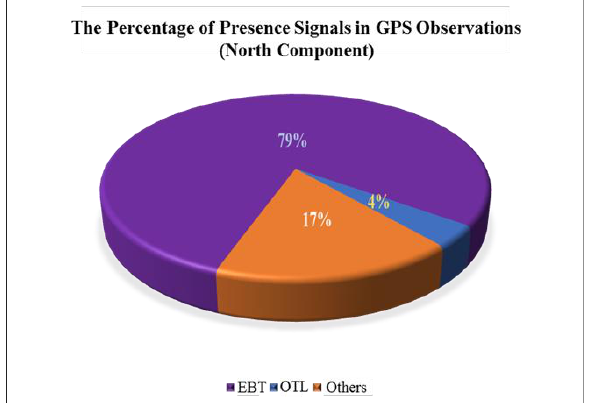
Figure 4. The average of presence signals in GPS observations at north component.